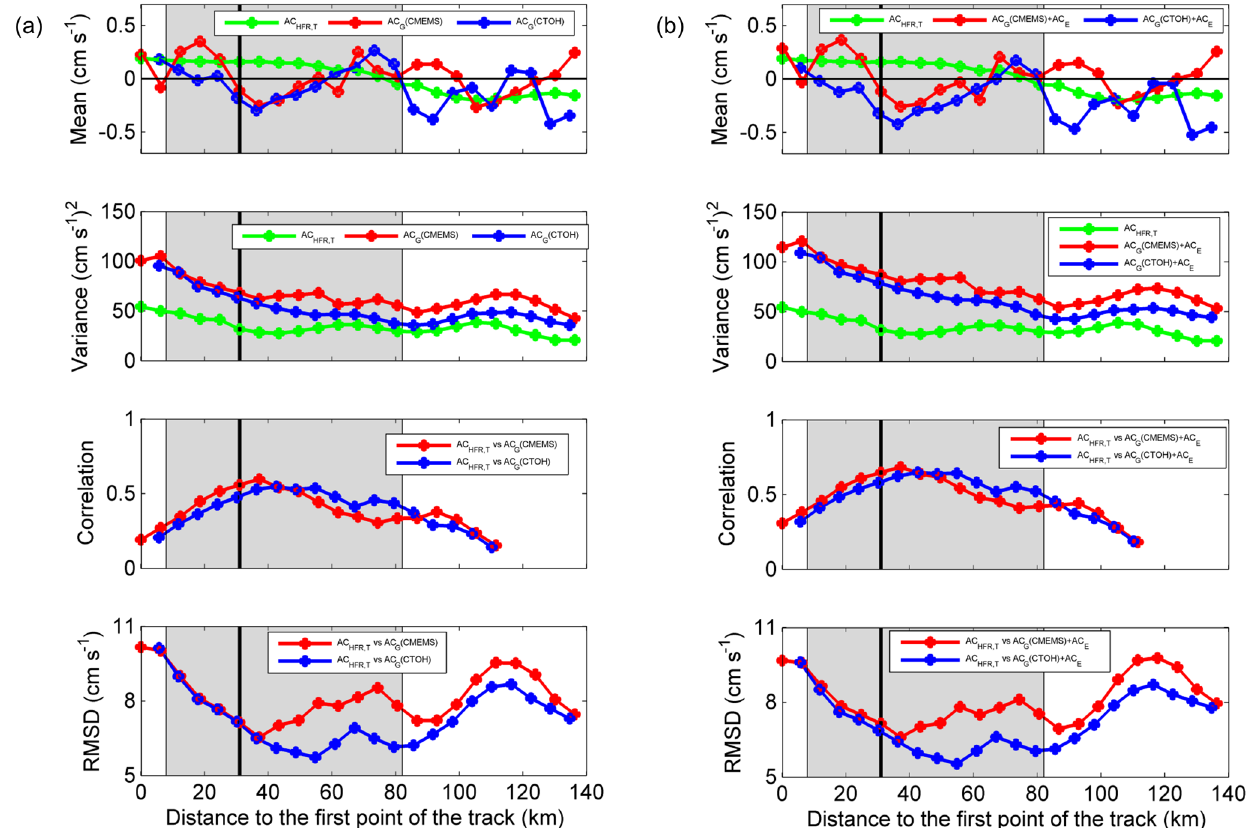
Figure 5. Mean and variance along track 248 of the different data sets – AC HFR , T , AC G (CTOH) and AC G (CMEMS) – and correlation and RMSD between (a) AC HFR , T and AC G and (b) AC HFR , T and AC G + AC E . The grey-coloured area corresponds to the slope between the 200 and 1000m isobaths. The black line is the location of the point E , and the first point of the track is around 11km away from the coast. Correlation values are not plotted for confidence levels under 90% (i.e. at the points along the track with a distance from the first point beyond 120km). Note that the first point is different for CTOH and CMEMS (which are around 10.5 and 13km away from the coast, respectively) and that the spacing between the points is slightly different. Moreover, the first point in CTOH is removed because it is an outlier. The radar points are the same as CMEMS